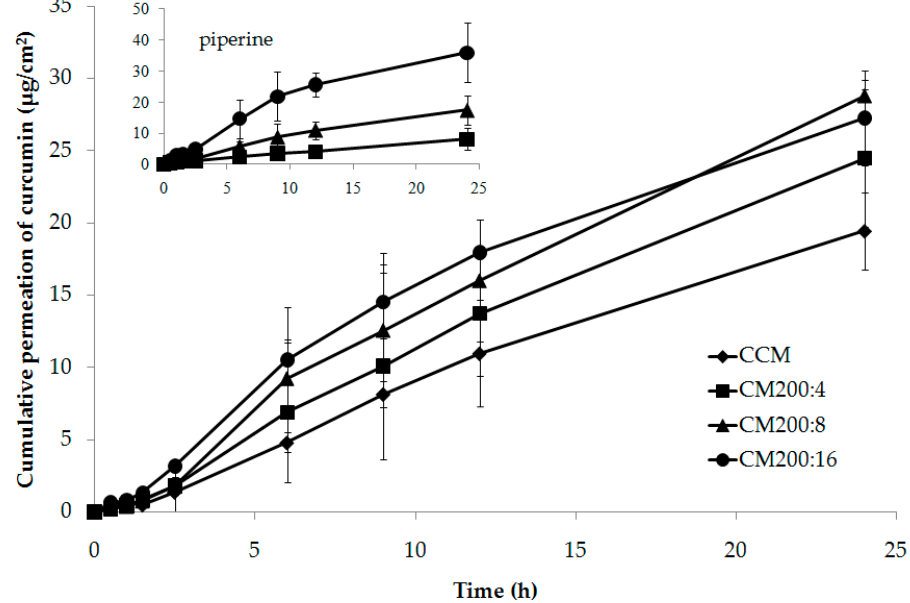
Figure 7. Permeation profiles of curcumin and piperine from different composite membranes compared with controlled composite membrane through mouse dorsal skin.